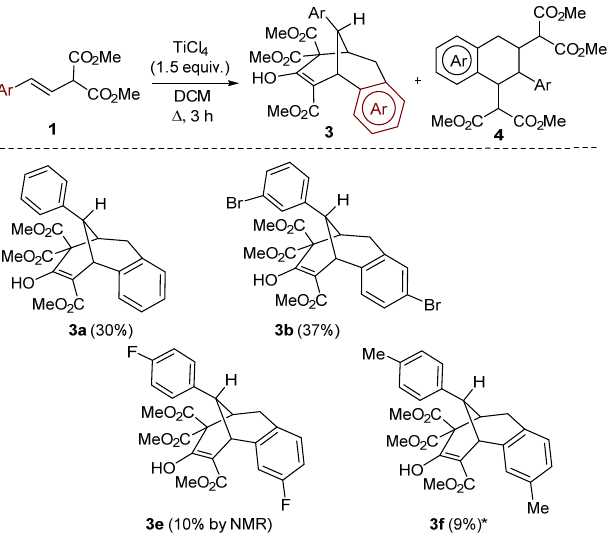
Scheme 3. Reactions dimerization/elimination for 9,10-dihydro-5,9-methanobenzo[8]annulenes 3 . * Formed as a minor compound under the conditions used to synthesize cyclohexadienol 2f.